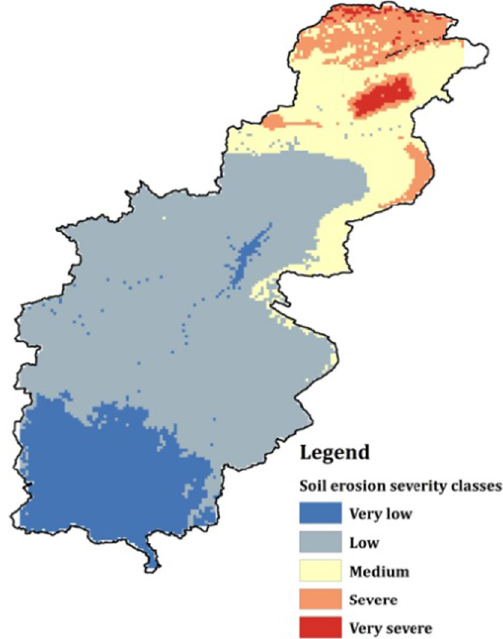
Fig. 8 Vulnerable areas classification map